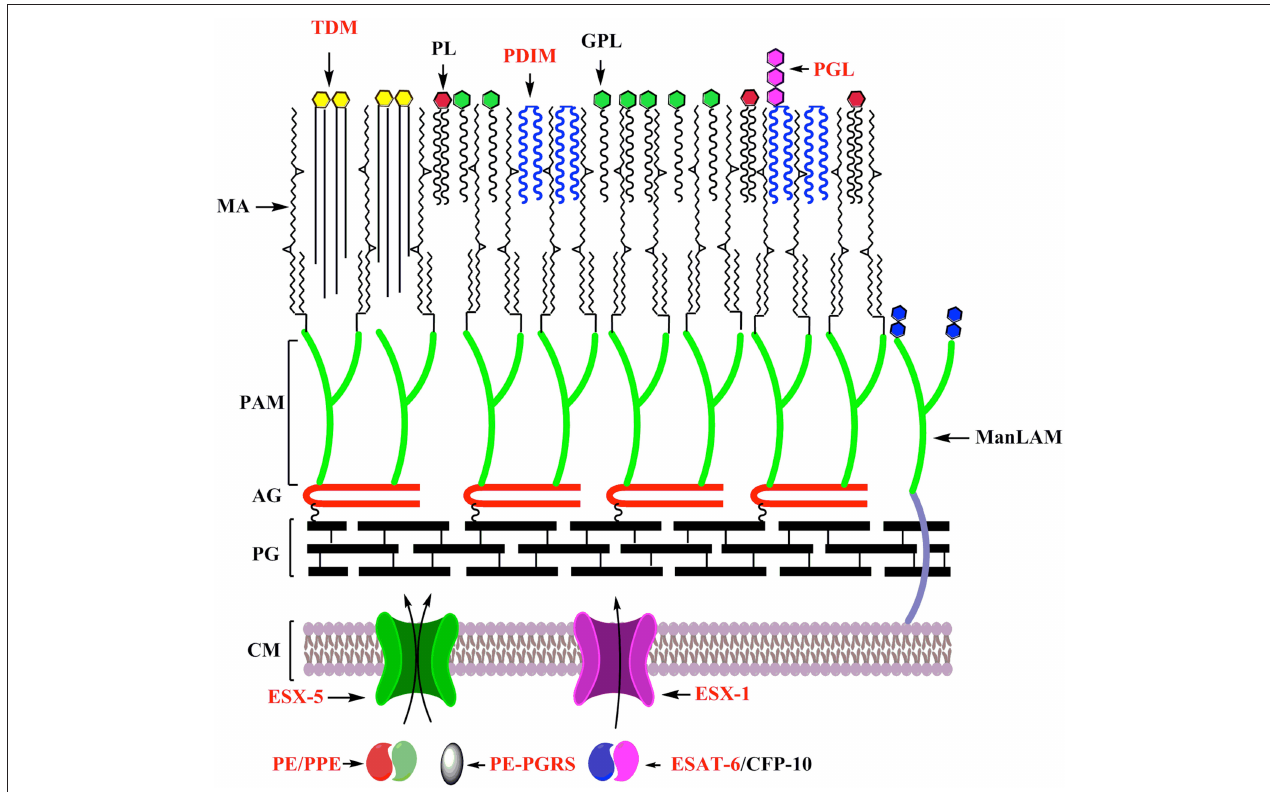
FIGURE 2 | Key features underlying the adaptation of mycobacteria as specialized pathogens: Cell envelope of mycobacteria with factors playing distinct roles in its adaptation as a specialized pathogens labeled in red. CM, Cell membrane; PG, Peptidoglycan; AG, Arabinogalactan; PAM, Penta arabinosyl motif; MA, Mycolic acids; TDM, Trehalose dimycolate; PL, Phospholipids; PDIM, Pthiocerol dimycocerosate; GPL, Glycopeptidolipids; PGL, Phenolic glycolipids; ManLAM, Mannose capped